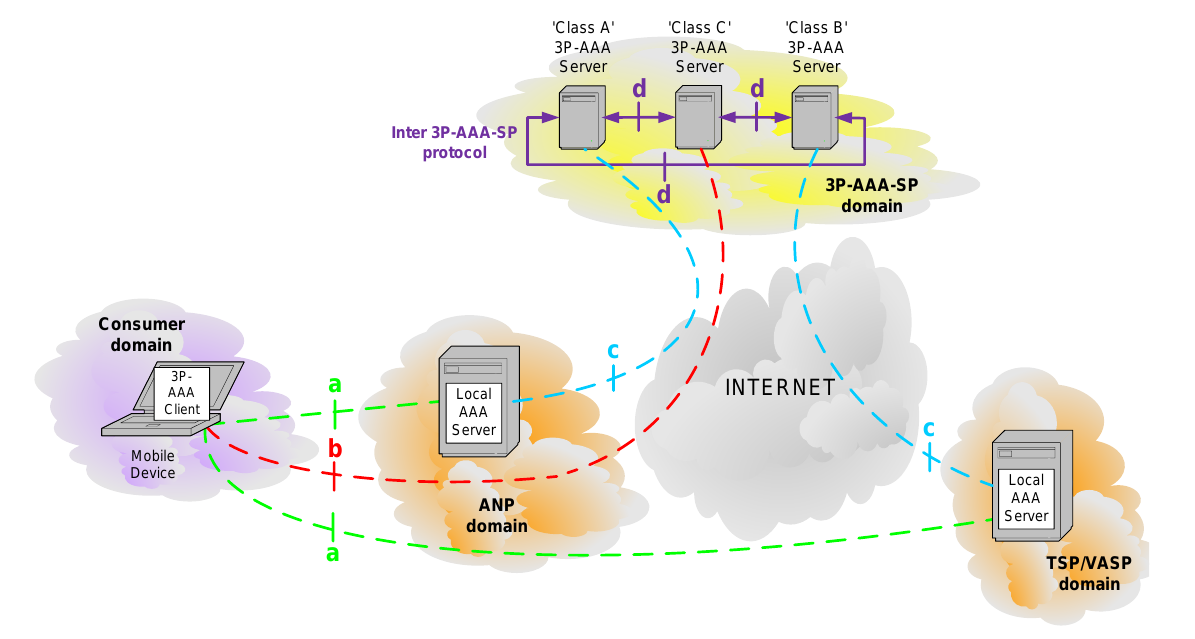
Figure 2. The 3P-AAA functional model with reference points for the four new interfaces a, b, c, and d. A market-segmented multi-class 3P-AAA-SP structure is shown.